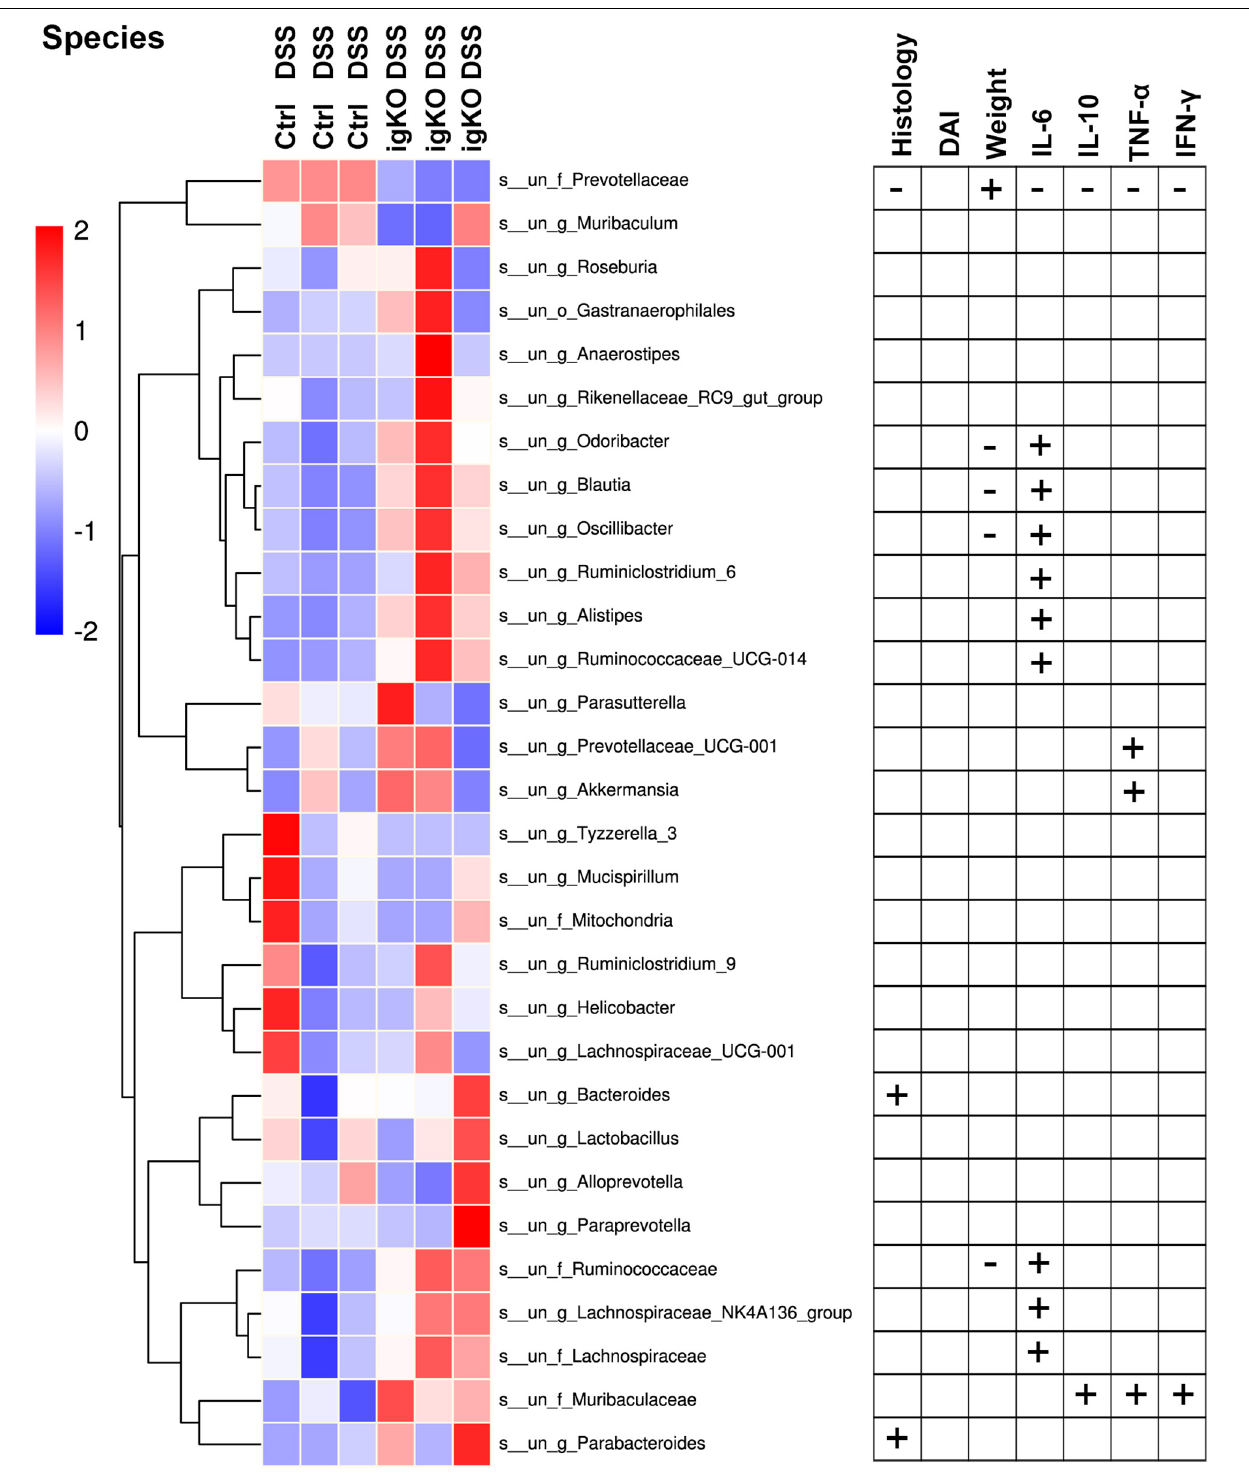
Frontiers in Microbiology |